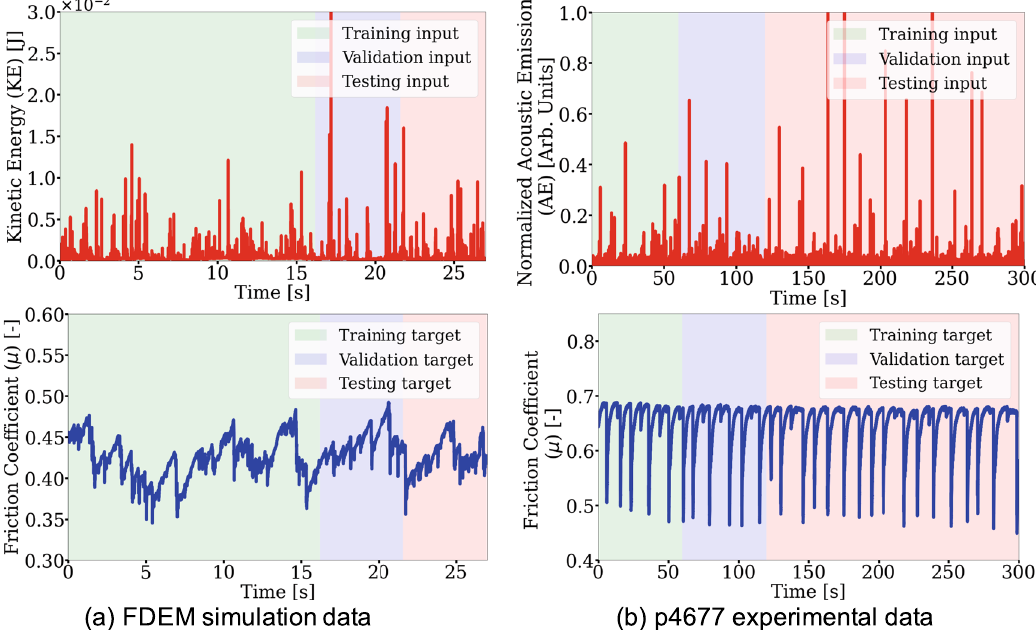
Fig. 2 Numerical simulation and experimental data used in the transfer learning analysis. The top row shows the deep learning model input signal as the kinetic energy and acoustic emissions, respectively, and the bottom row shows the target friction coef fi cient. a Finite-discrete element method (FDEM) time series are split into training/validation/testing segments (60/20/20%) shown in green, blue, and pink shades, respectively. The convolutional encoder-decoder is fully trained and tested using these data. b The experimental data (p4677) are split into training/validation/testing segments (20/20/ 60%) to include six cycles of stick-slip events for training the model latent